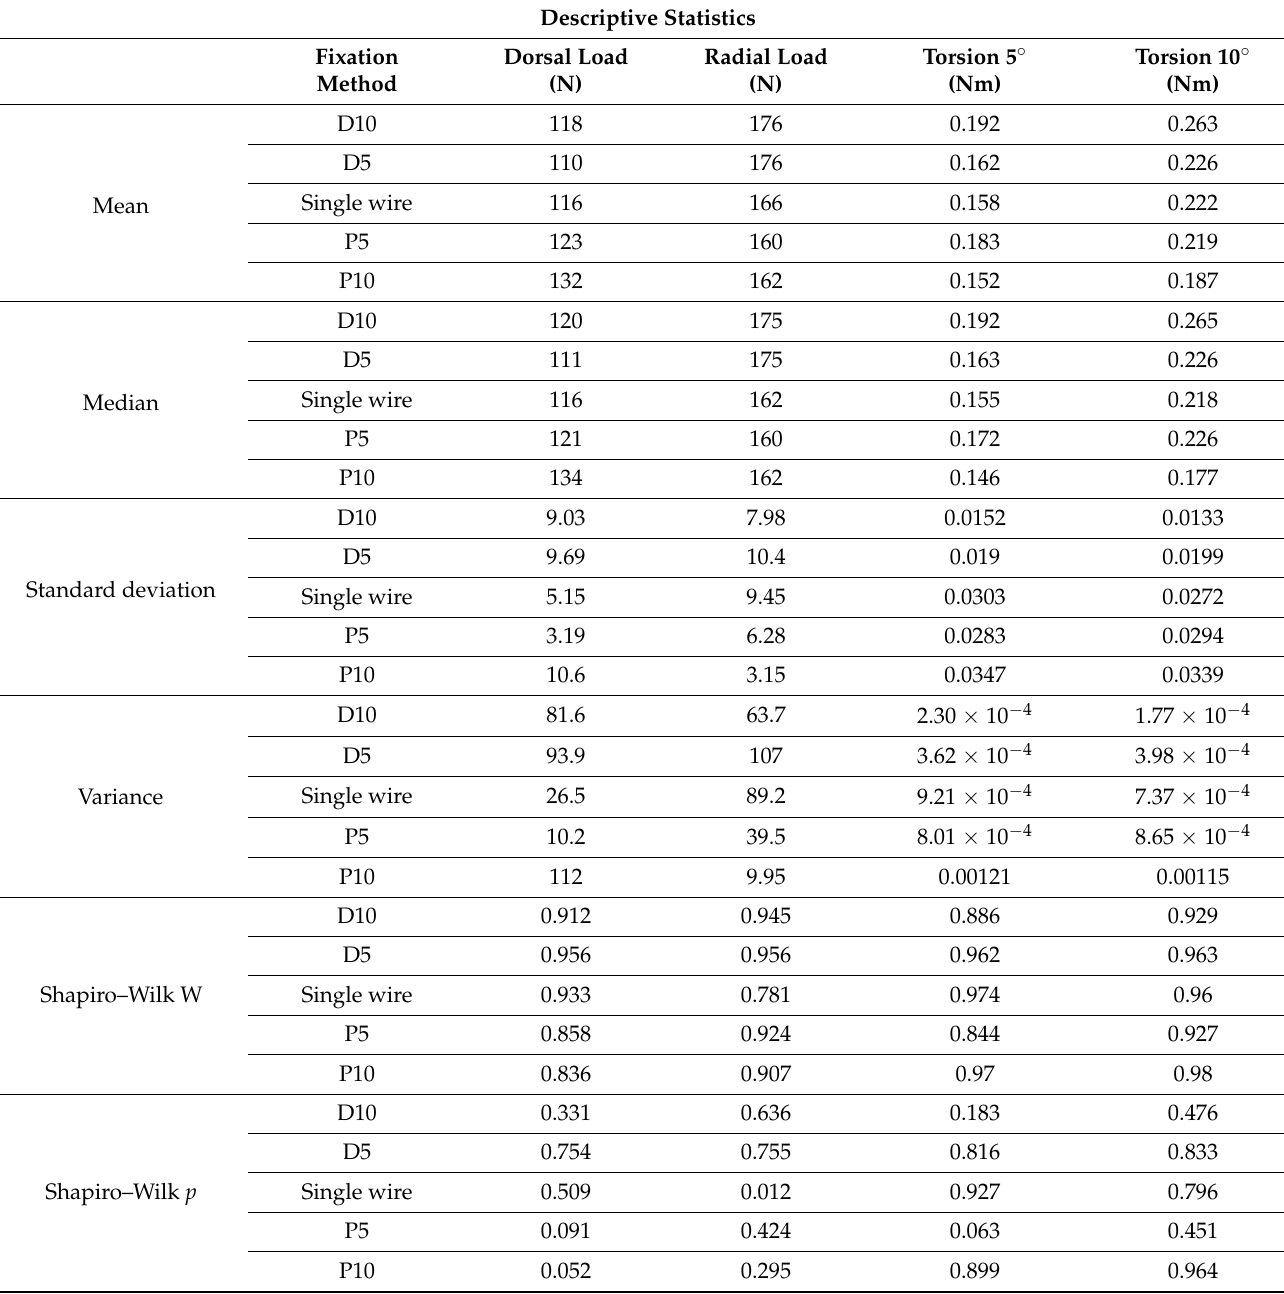
Table A7. Descriptive statistics of the single wire group and subgroups (Group III, Group III/D10, D5, P5, P10). The table contains the means, the medians, the standard deviations, the variances, and the Shapiro–Wilk W and p